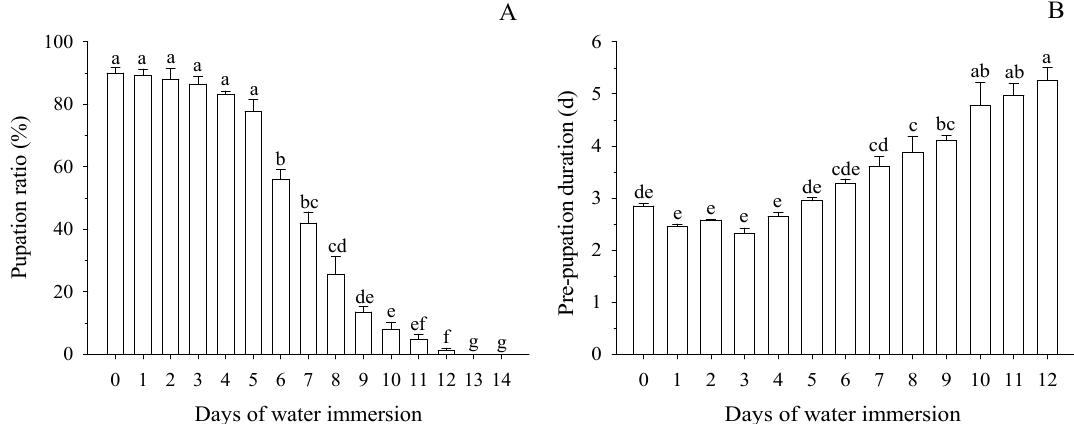
Figure 2. E ff ects of water immersion on the performance of pupation. ( A ): Pupation ratio of larvae in di ff erent days of water immersion. ( B ): Pre-pupation duration of larvae in di ff erent days of water immersion. Means ( ± SE) among di ff erent lengths of immersion followed by di ff erent letters di ff er at p < 0.05 (Tukey HSD test). Table 1. Curve equation from a regression between immersed days and recovery ratio of knocked- out larvae within 24 h, larvae mortality ratio, and pupation ratio of larvae of B. minax .